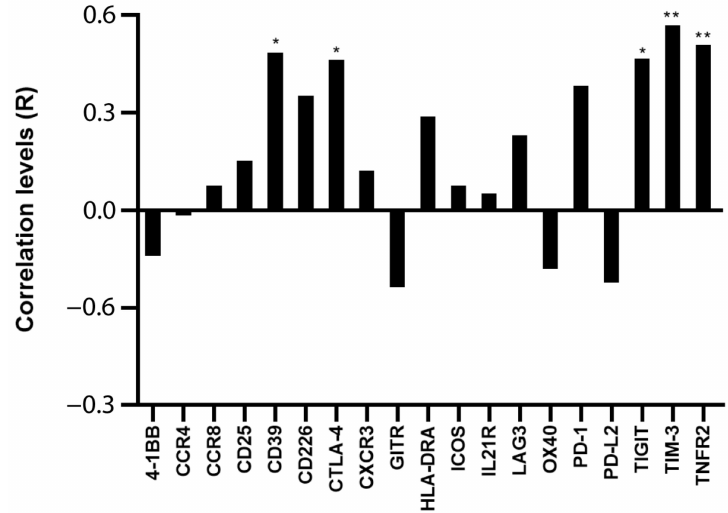
Figure 2. Correlation between Ki-67 and Treg/CD8 exhaustion markers. The rho factor of corre- lation (R) between mRNA expression of Ki-67 and normalized mRNA expression of Treg/CD8 exhaustion markers is reported. Data are evaluated without cleaning any outlier. The correlation significance was evaluated using Pearson and Spearman tests. * p < 0.05, ** p < 0.01.